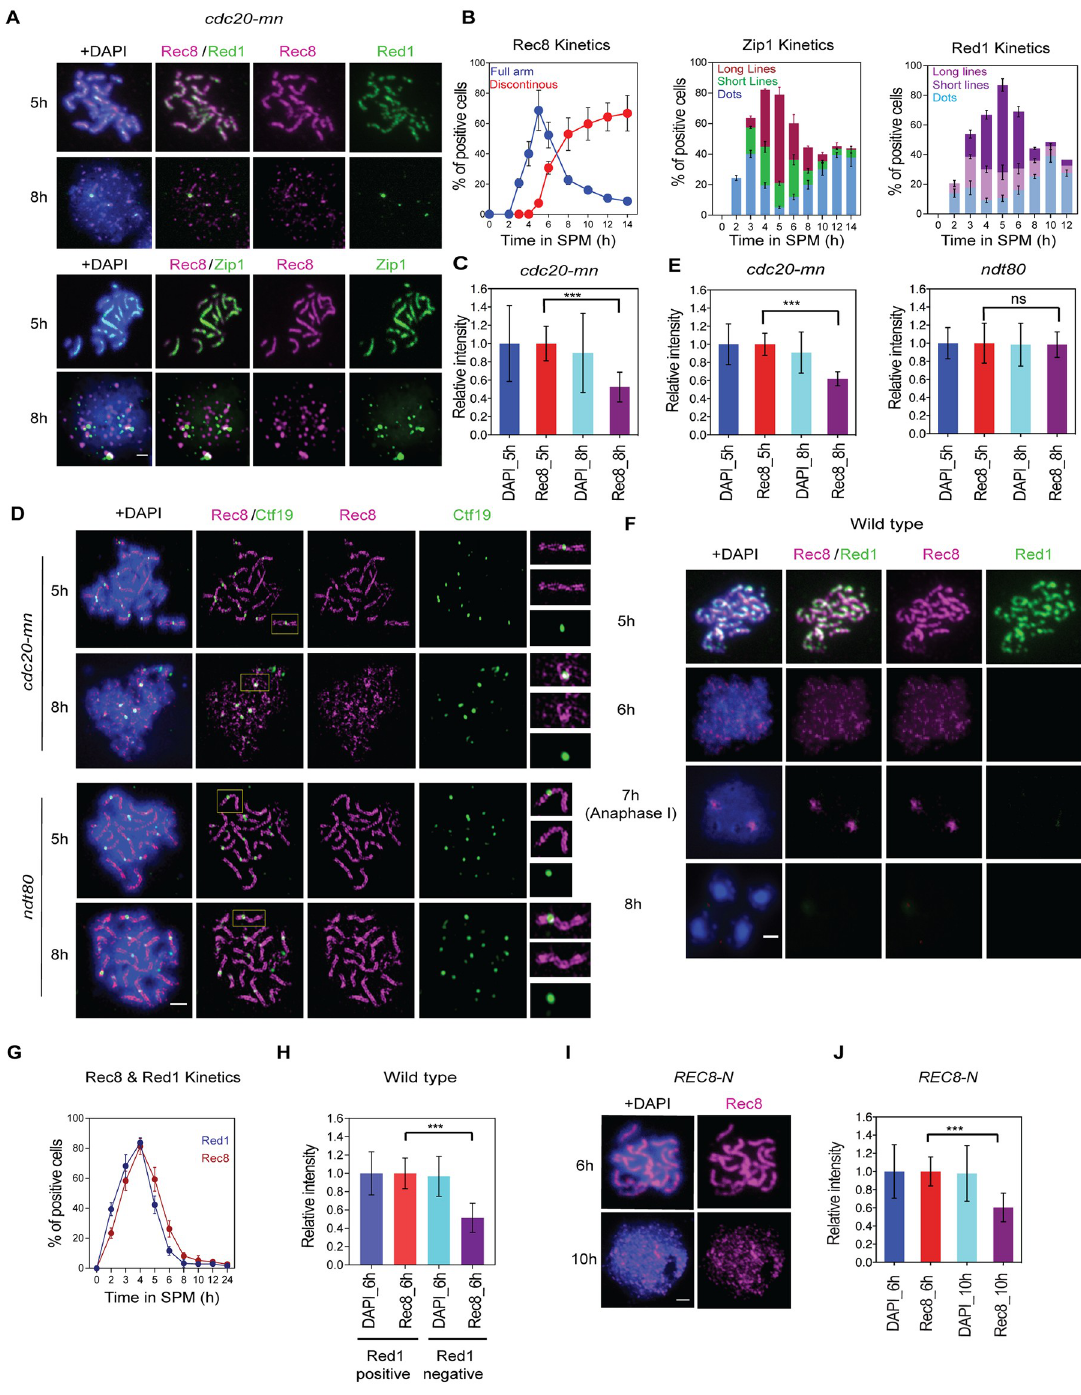
Fig 1. Rec8 shows dynamic localization in late meiotic prophase-I. (A) Immunostaining analysis of Rec8 (red) and axis protein Red1 (green; top) and Rec8 (red) and SC protein Zip1 (green; bottom) in cdc20-mn (KSY642/643) strain. Representative image with or without DAPI (blue) dye is shown. Rec8 staining in the cdc20-mn was classified as linear (5 h) and altered (8 h) classes. The bar indicates 2 μ m. (B) Kinetics of Rec8 (left), Zip1 (middle) and Red1 (right) staining in cdc20-mn (KSY642/643) strain was analyzed. A minimum 100 cells were counted at each time point. Error bars (Rec8) show the standard deviation (S.D.; n = 3). Rec8 staining is classified; full (blue) and discontinuous dotty (red) staining. Zip1 staining is classified as follows: dotty (blue); short linear (green); full linear staining (red). Red1 staining is classified as follows; dotty (light blue); short linear (light purple); full linear staining (purple). (C)Total signal intensity of